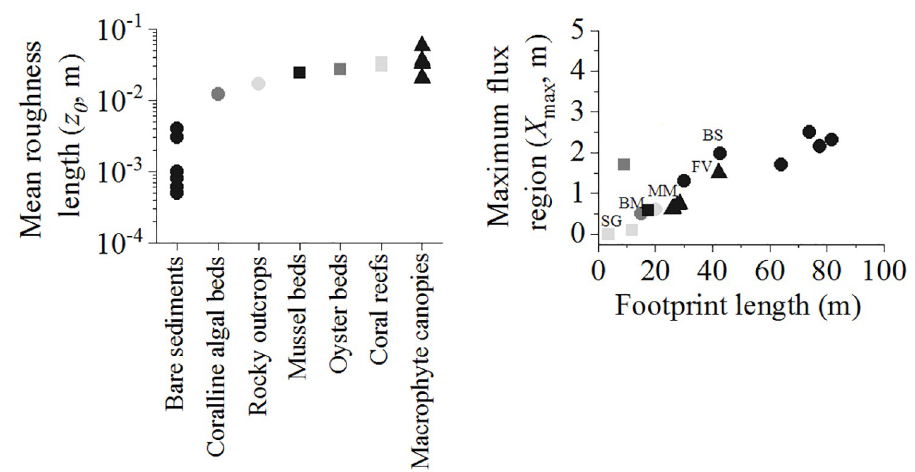
Fig 4. Estimated characteristics of the AEC footprint. Mean roughness length (z 0 ) and estimated footprint length versus region of maximum flux contribution (X max ) for various coastal benthic habitats (Bare sediments: